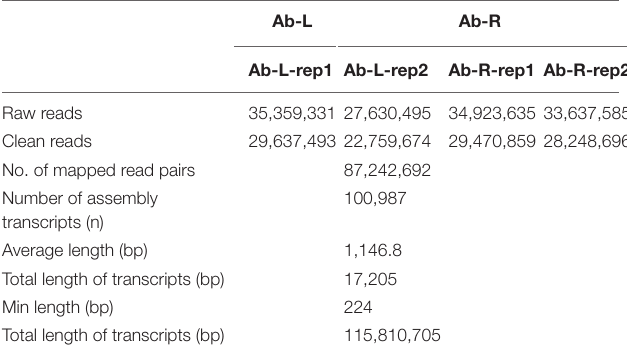
TABLE 2 | Summary of Illumina transcriptome sequencing for leaves and roots of Achyranthes bidentata